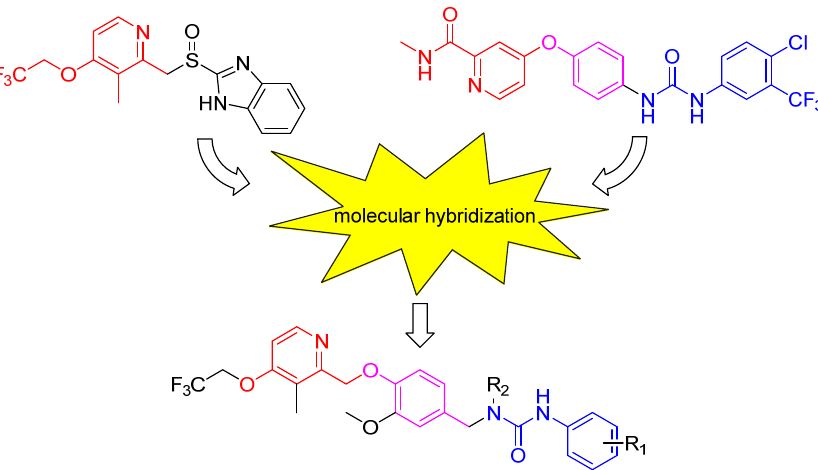
Figure 3. Design of target compounds with molecular hybridization strategy.